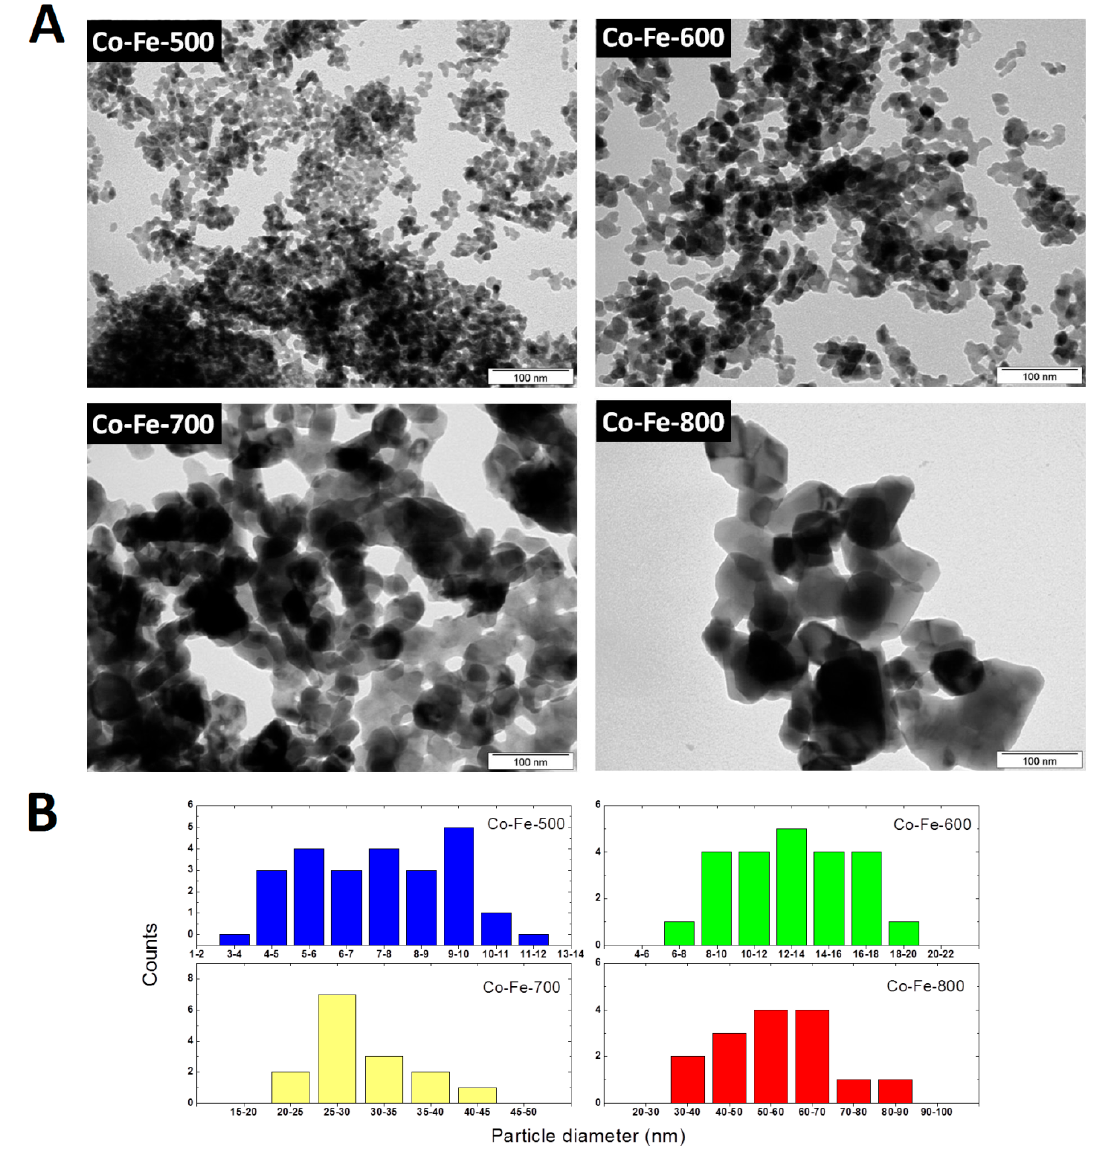
Figure 7. ( A ) TEM micrographs of synthetized nanoparticles; ( B ) particle size distribution obtained by image analysis.